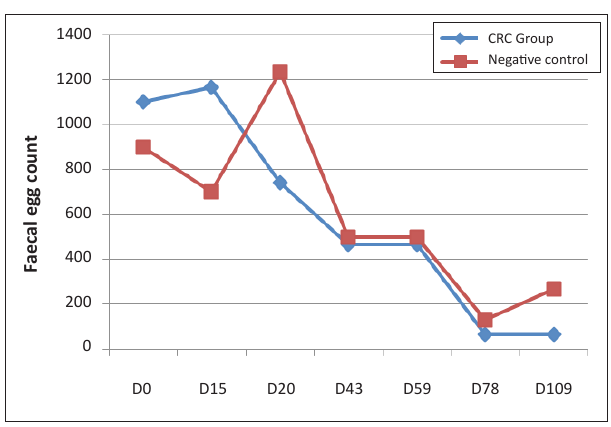
FIGURE 1: The arithmetic mean faecal egg count scores of individual animals (unpooled).